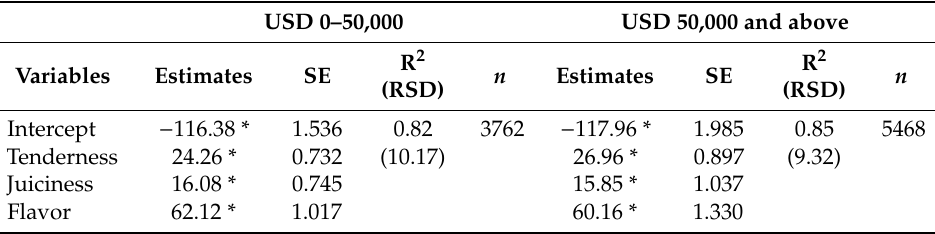
Table 11. Pairwise comparisons of income groups on consumer